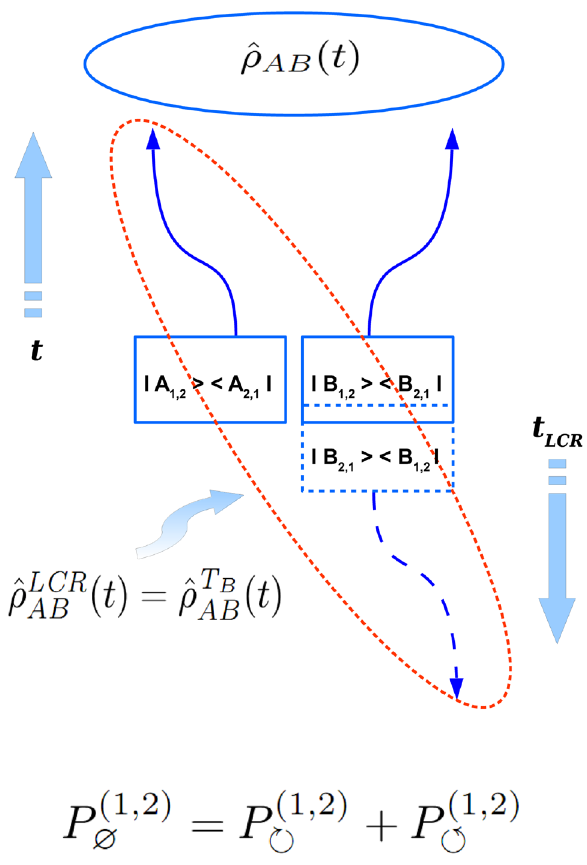
4 (two qubit- ) density matrix evolution in the separable case with respect Figure 1. Schematic picture of 4 × to the local causality reversal (LCR-) procedure applied to B -subsystem which is possible in the separable case. t LCR 0 . Such Square blocks are supposed to mark a moment of a given density matrix preparation at t = = preparation involves statistically independent virtual quantum transitions in both subsystems depicted by means of projectors in the blocks (here the solid blocks start forward time evolution while dashed block marks the start of locally causal-reversed evolution of B-subsystem) . Since all blocks for A- and B subsystems are disconnected from each other in the separable case, the LCR-procedure on each subsystem makes sense and hence any LCR- 2 Hilbert space maintains its probabilistic sense ρ LCR AB ( t ) from 2 (or pt-) transformed separable density matrix ⊗ ˆ in such the